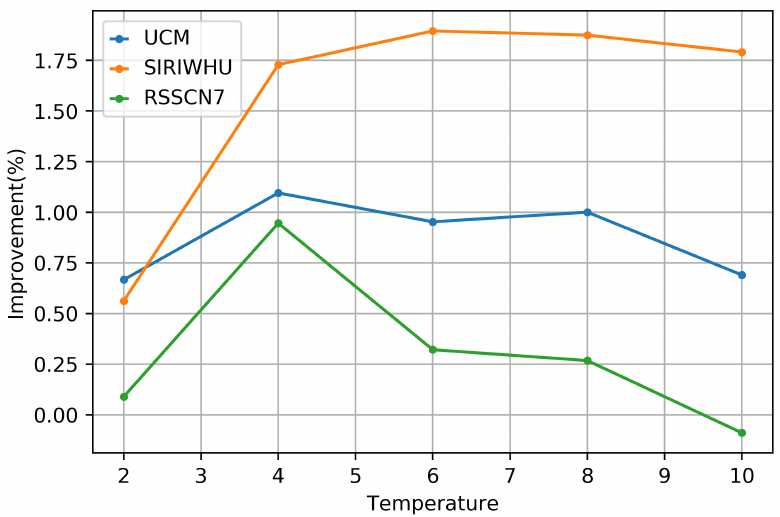
Figure 12. The diagram of influence of temperature T .